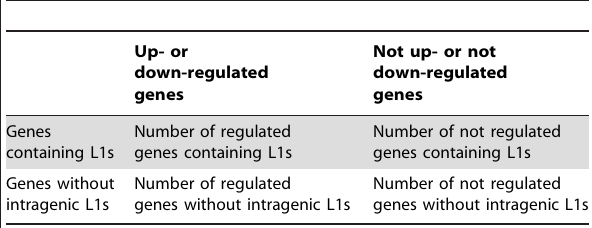
Table 1. 2 6 2 table of chi-square test to evaluate if intragenic L1s can influence host gene expression.